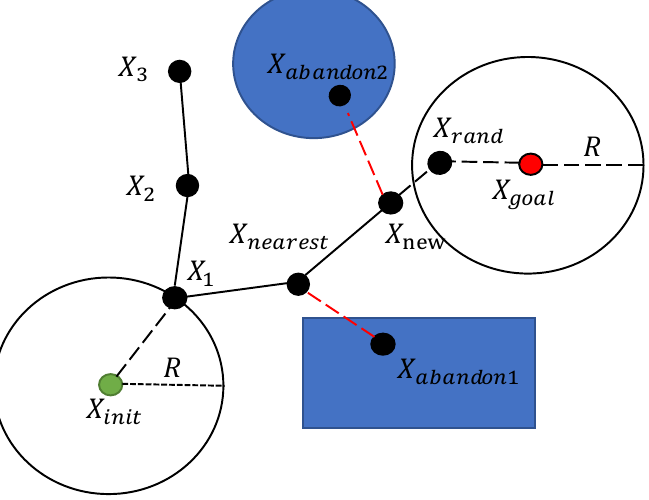
Figure 3. RRT algorithm random tree expansion process.